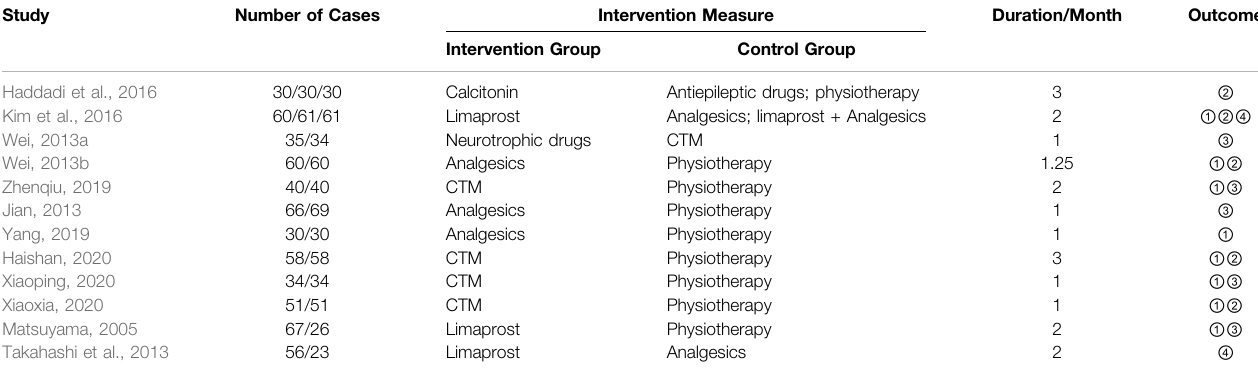
TABLE 1 | Characteristics of included studies.